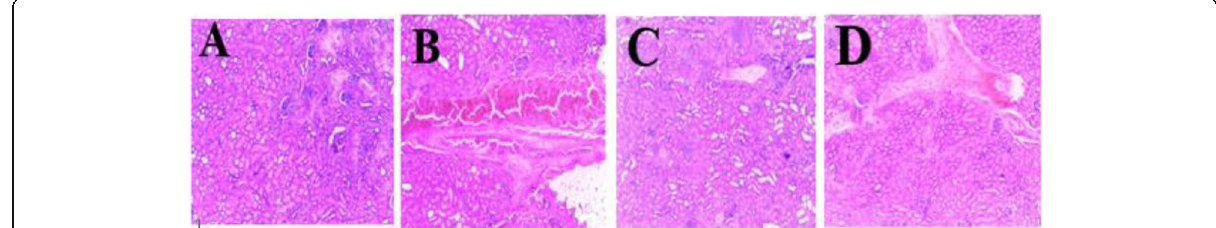
Fig. 2 a - d Shows photomicrographs of kidney tissue of rats. a (control): A cross section of kidney in control rat with arrow showing normal histological appearance of the glomerulus and the tubules (× 100 magnification). All sections were stained with haematoxylin and eosin. b A cross section of the kidney of rat treated with 250 mg/kg of the ethanol extract of Harungana madagascariensis with arrow showing congestive changes (× 200 magnification). All sections were stained with haematoxylin and eosin. c A cross section of the kidney of rat treated with 500 mg/ kg ethanol extract of H. madagascariensis lam with arrow showing dilated and congested vessel. (×200 magnification). All sections were stained with haematoxylin and eosin. d A cross section of the kidney in rat treated with 1000 mg/kg ethanol extract of H. madagascariensis lam with arrow showing dilated and congested vessels. All sections were stained with haematoxylin and eosin. (×200